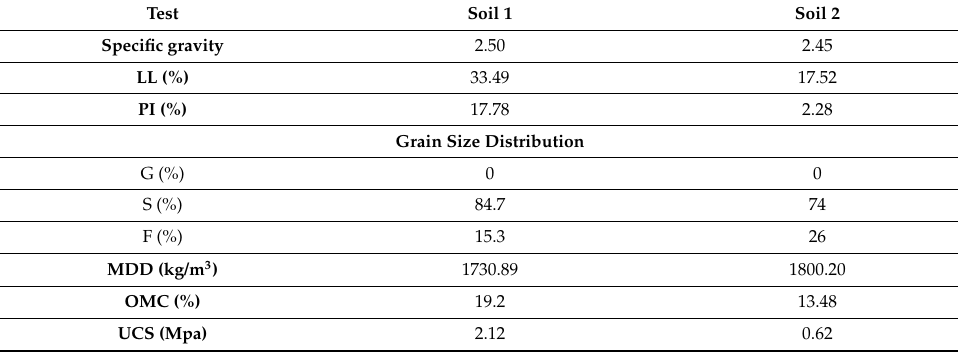
Table 7. Geotechnical properties of the selected